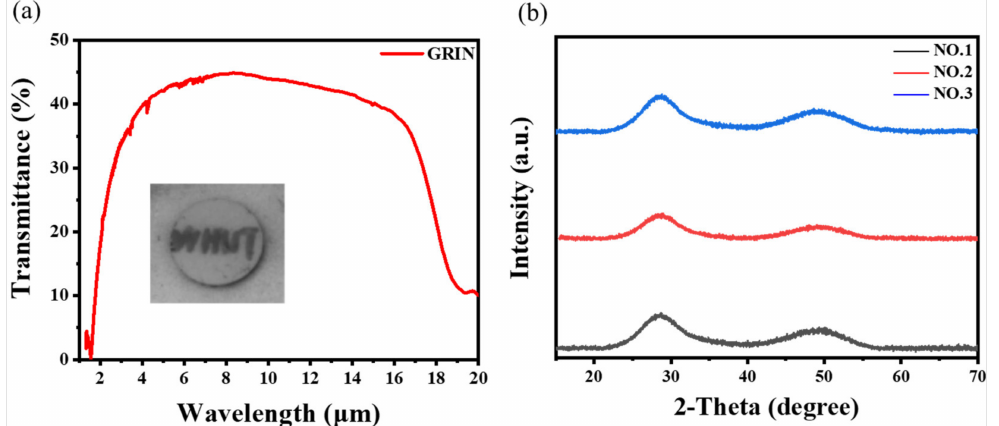
Figure 5. ( a ) Infrared transmittance of the samples after hot pressing diffusion polishing. The inset is an infrared photograph of the GRIN lens, thickness: 2.82 mm; ( b ) XRD spectra of the GRIN lenses.